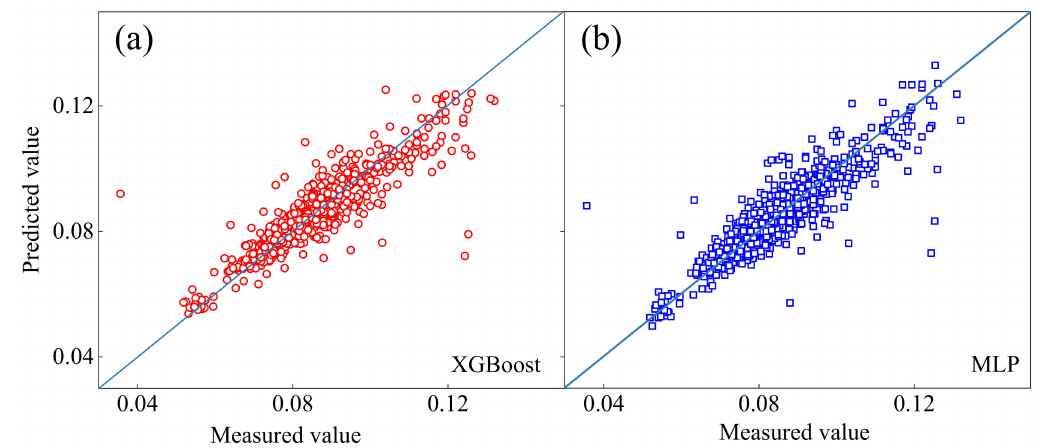
Figure 8. The fitting of the XGBoost ( a ) model and MLP model ( b ).